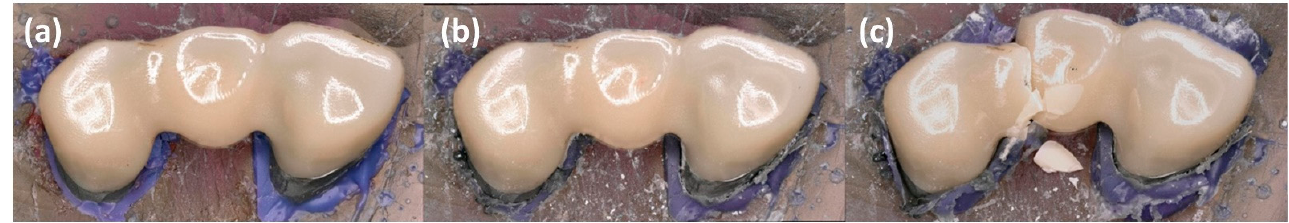
Figure 4. Representative specimen after ( a ) manufacturing, ( b ) aging and ( c ) fracture load test.